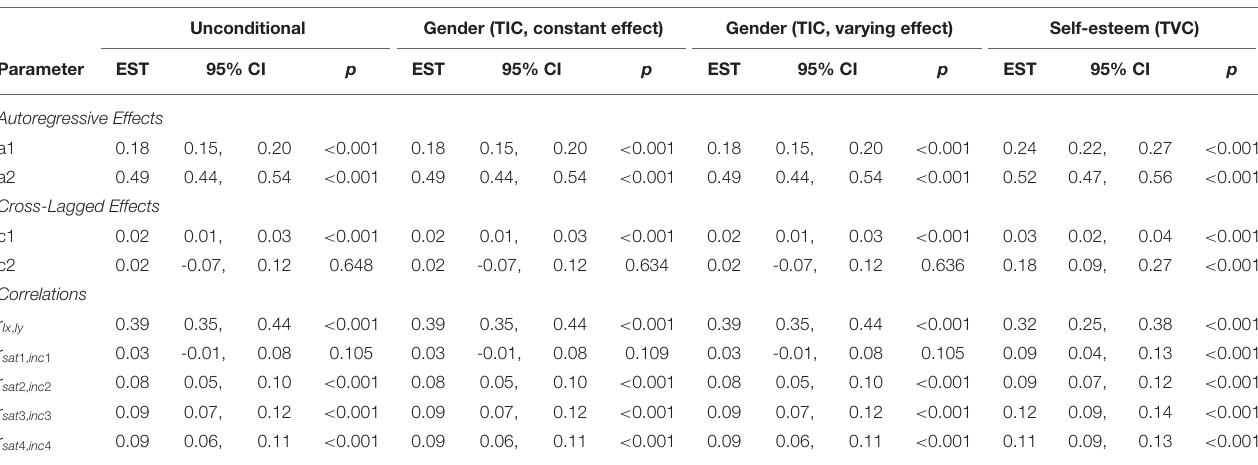
TABLE 3 | Comparison of RI-CLPM